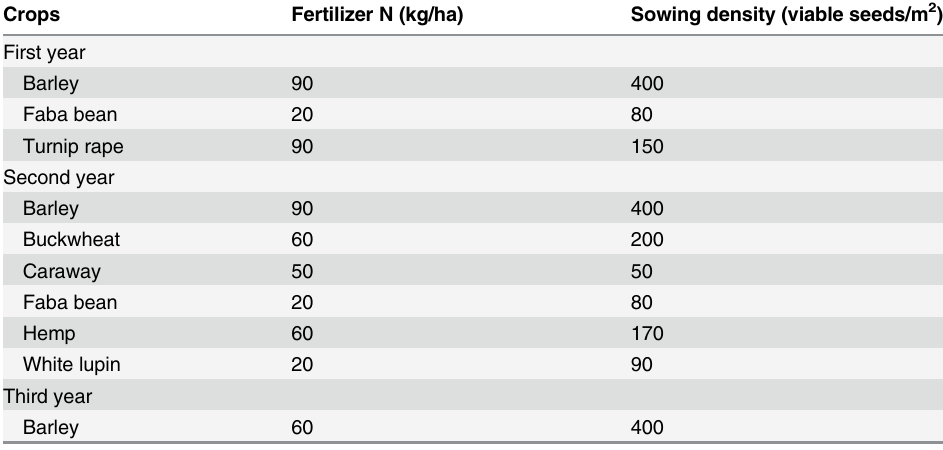
Table 1. Crops, fertilizer use (N kg/ha) and sowing density (viable seeds/m 2 ) in the experiments (2010 – 2012, 2011 –